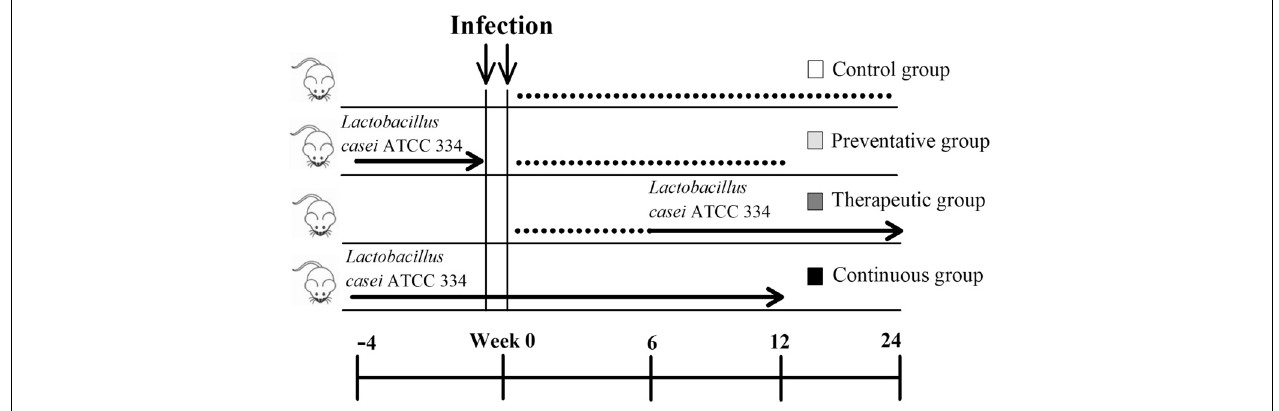
FIGURE 5 | Experimental design of Lactobacillus casei ATCC 334 feedings. Three Lactobacillus casei ATCC 334 trials were conducted (preventative, therapeutic and continuous) along with a control. All mice were inoculated with two doses of 10 9 CFU of M. avium subsp. paratuberculosis K10 on two consecutive days. The blue arrows represent